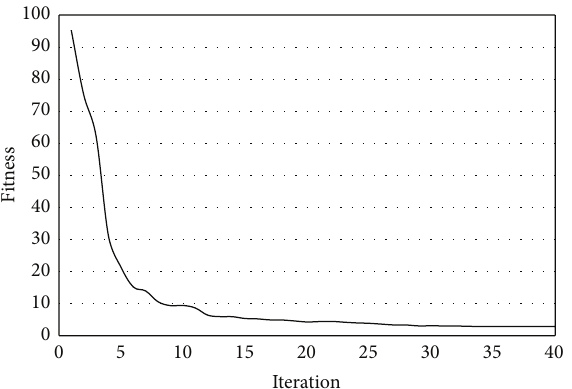
Figure 11: Iteration history for case study 1.